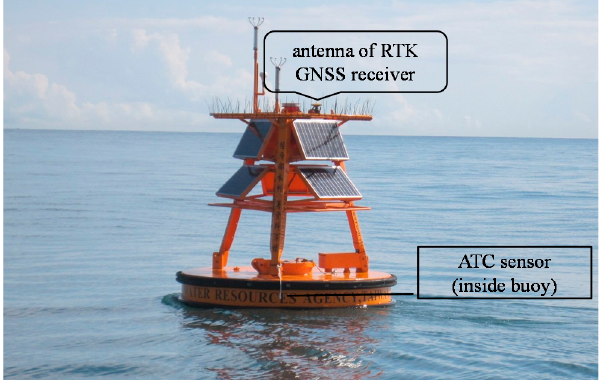
Figure 4. Snapshot of the GNSS buoy deployed in the waters of Suao, Taiwan.